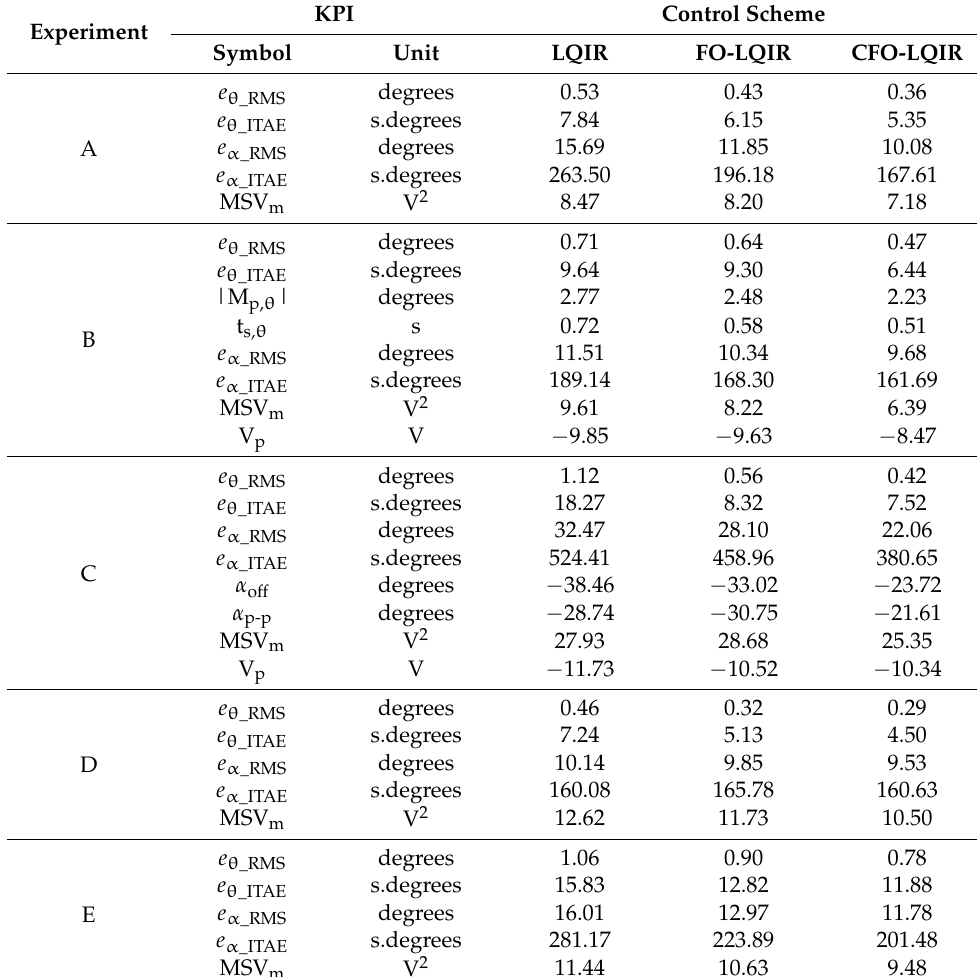
Table 2. Summary of experimental